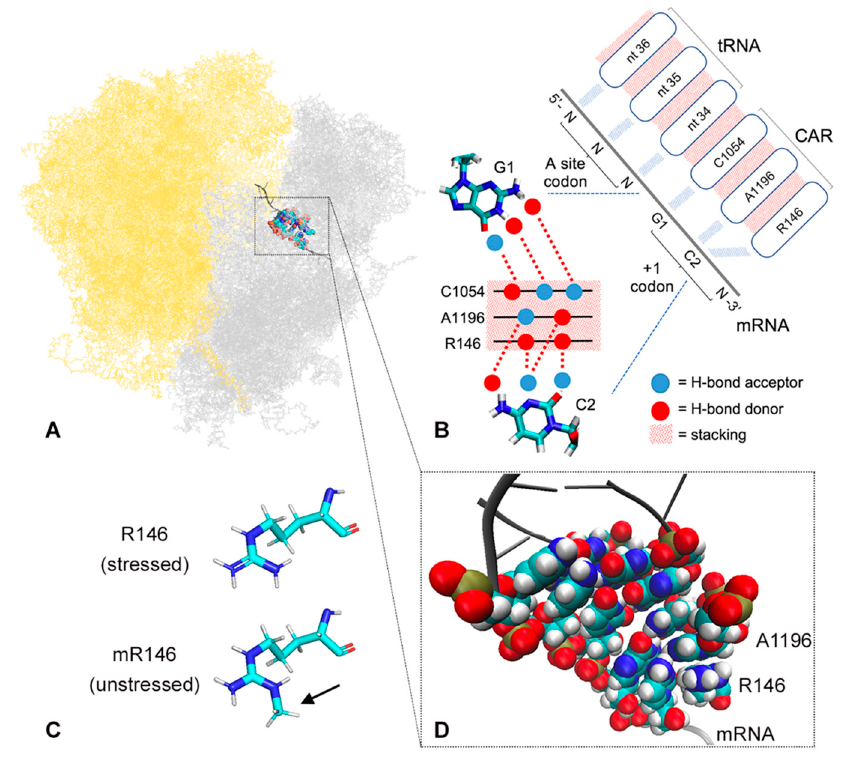
Figure 1. The CAR interaction surface. ( A ) Cryo-EM structure (PDB ID 5JUP; [17]) of translocation stage II yeast ribosome showing large (yellow) and small (grey) subunits. Additionally, highlighted in color are the A site codon/anticodon, CAR interface, and +1 codon next to enter the A site. ( B ) Cartoon showing interaction between the CAR interface and first (G1) and second (C2) nucleotides of the +1 codon. H-bond donors are illustrated in red and H-bond acceptors in blue. ( C ) Rps3 R146 is hypothesized to be ω -N G -monomethylated (arrow) in unstressed cells, and unmethylated in stressed cells. ( D ) van der Waal sphere representation of CAR interface showing stacking between the R146 guanidinium group and the A1196 base of the CAR interaction surface. Atoms are colored: N (blue), C (cyan), O (red), H (white), P (olive).